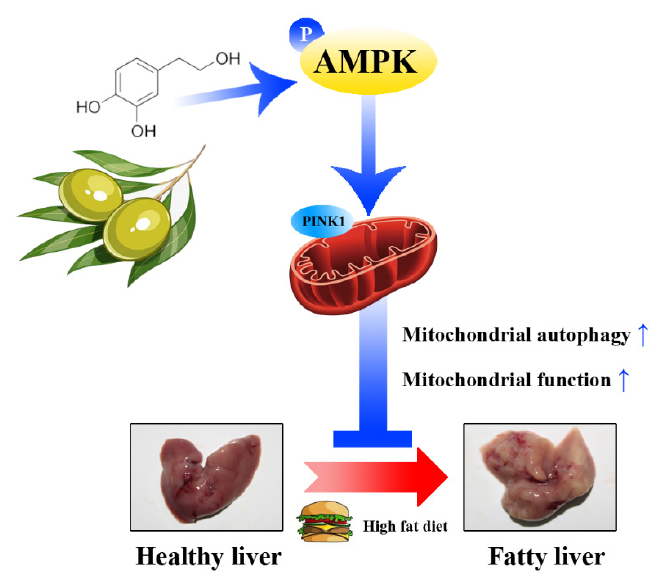
Figure 10. A schematic diagram showing the main internal mechanism of the lipid-lowing effect of HT. HT activates mitochondrial autophagy through the AMPK/PINK1 pathway, promotes mitochondrial function, which alleviates hepatic fat accumulation.